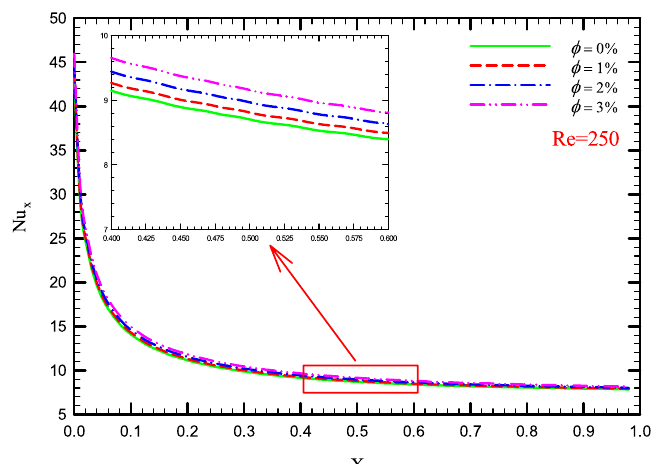
Figure 18. Nu x versus dimensionless length in Re = 250 for Case 2.